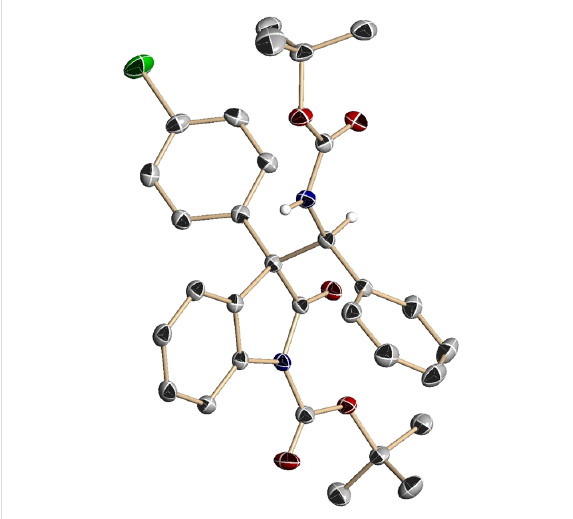
Figure 2: ORTEP diagram of 4ca (Ellipsoids displayed at 50% proba- bility. Calculated hydrogen atoms except it attaches to stereogenic car- bon are omitted for clarity. Black: carbon, Red: oxygen, Blue: nitrogen, Green: